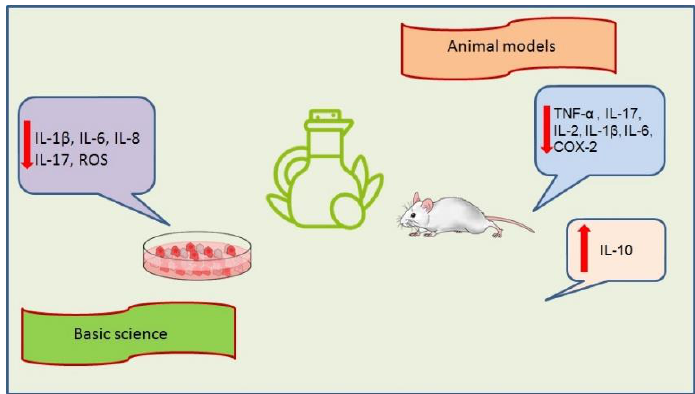
Figure 5. Biophenols from olive tree and intestinal inflammation: results from basic science and animal models. The red arrows pointing up indicate an increase while the red arrows pointing down indicate a decrease.